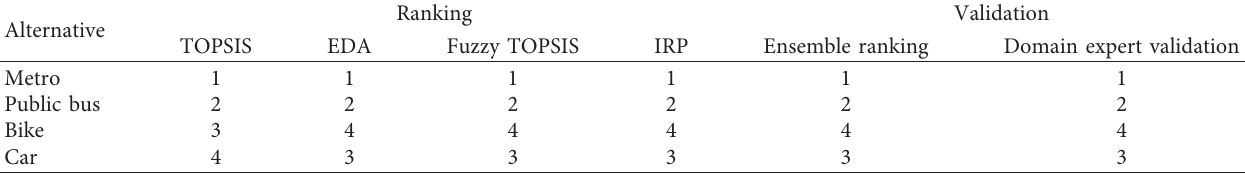
Table 14: Comparison of final experts’ ranking with the above-computed